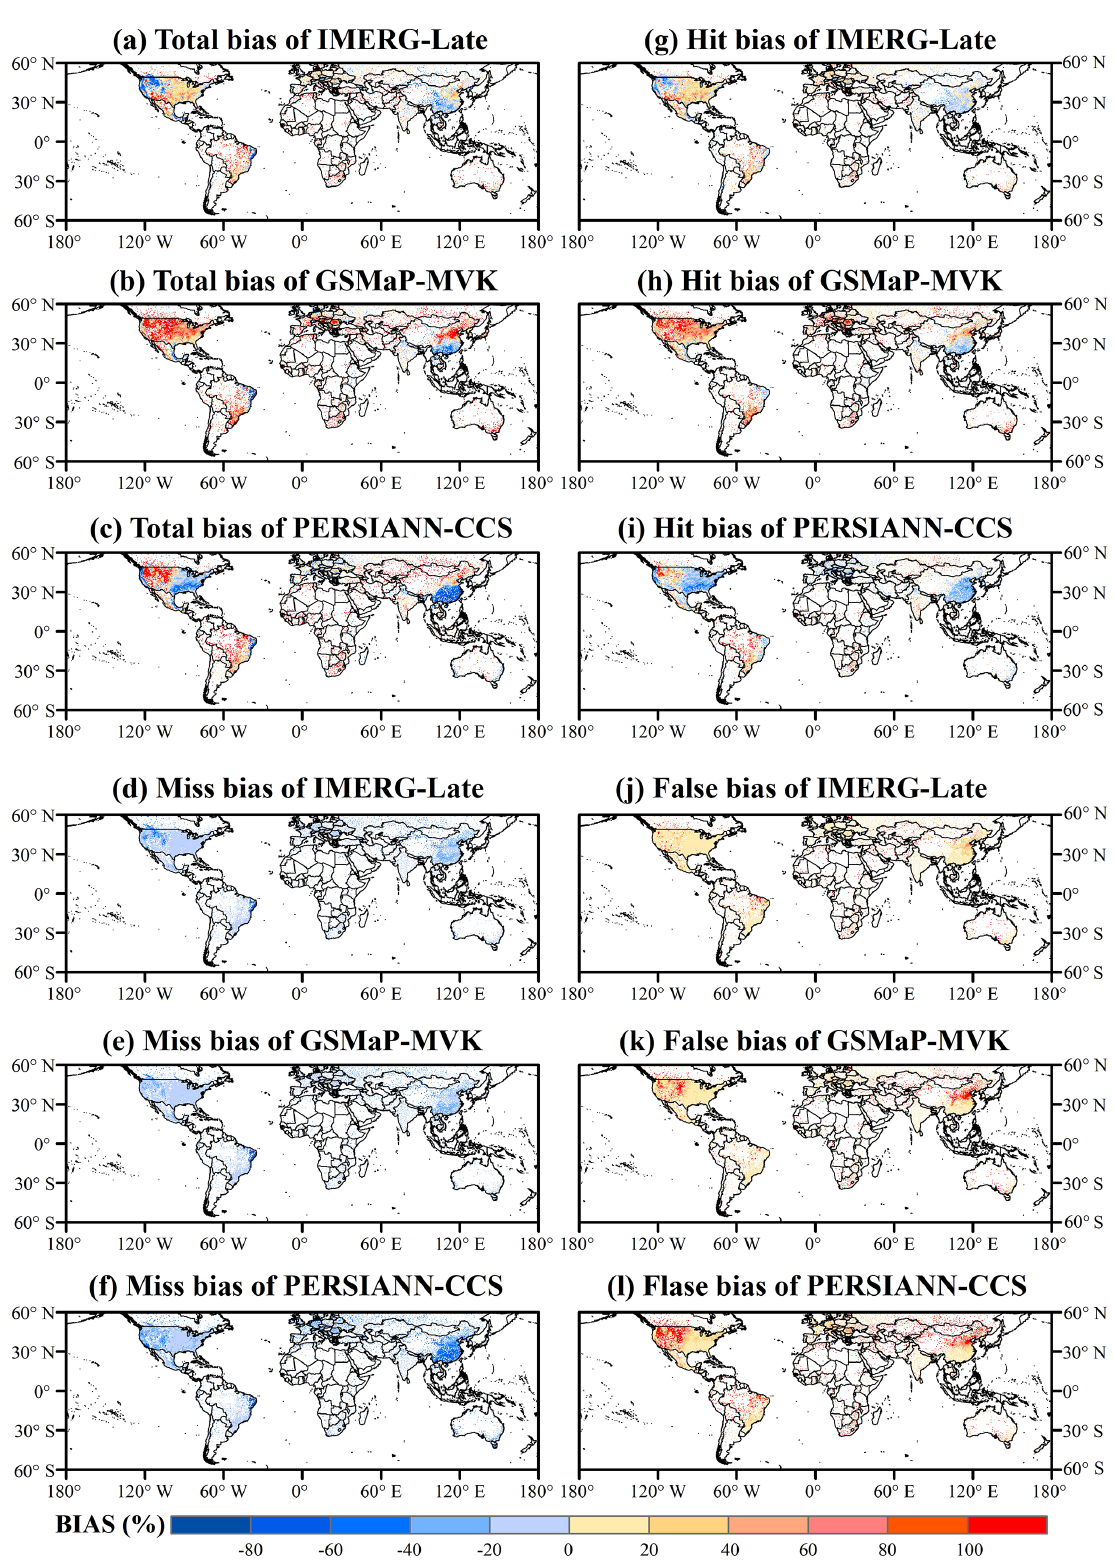
Figure 4. Global land maps of the total bias and its three independent components for the three satellite-only global precipitation estimates (i.e., IMERG-Late, GSMaP-MVK, and PERSIANN-CCS) at a spatial resolution of 0.5 ◦ and daily temporal resolution during the SON